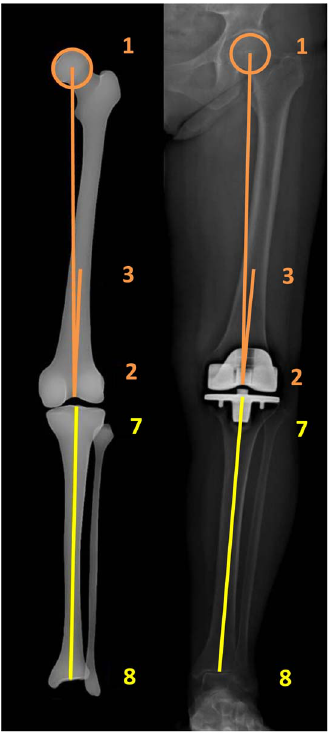
Figure 1. Identification of the lower limb on the frontal image. doi:10.1371/journal.pone.0104613.g001 3. Adjustment of the position of the point in the center of the femoral notch and tibial plateau, and marking of the femoral condyles. The condyles have to be identified on the AP and LAT images using the two spheres. It is possible to adjust the